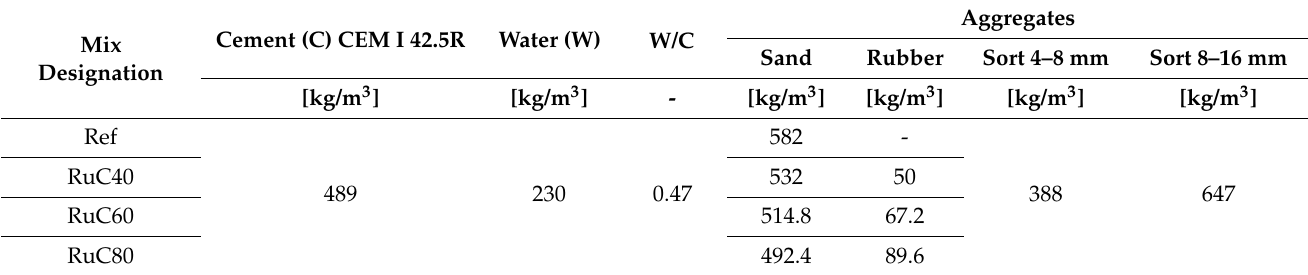
Table 1. Mix proportions used in the research.